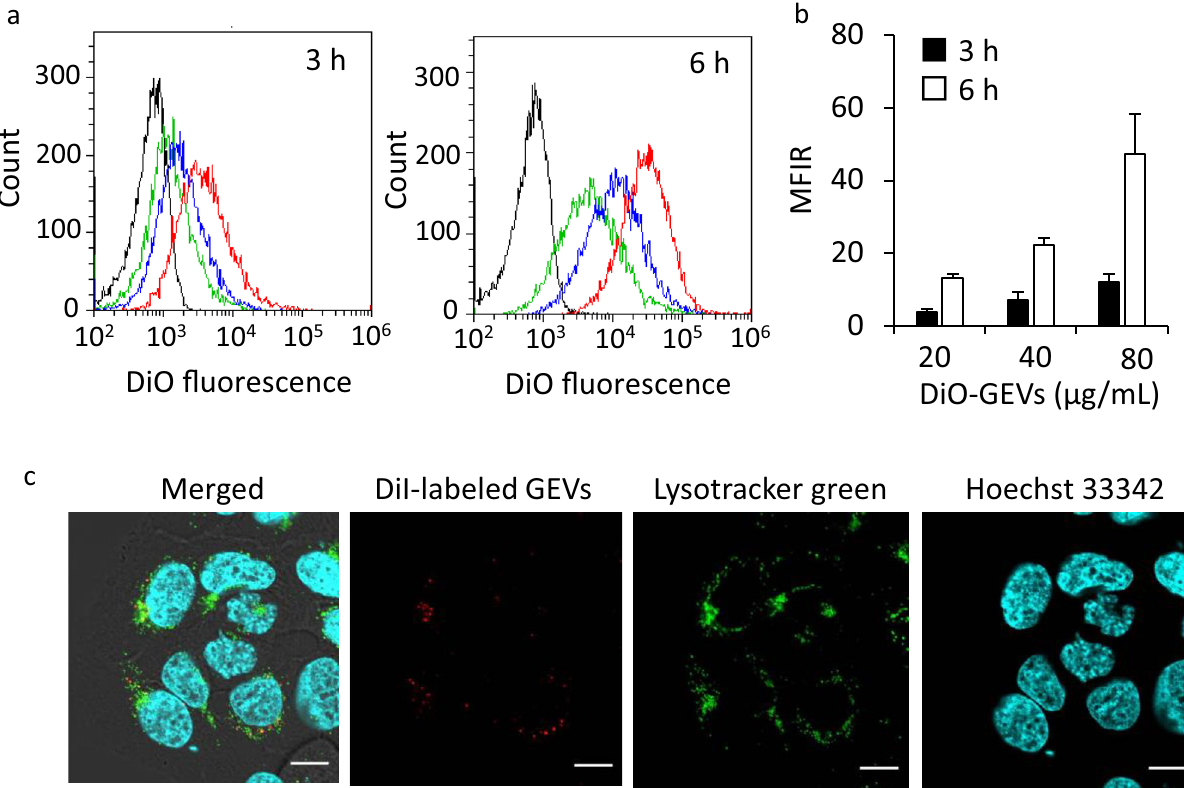
Figure 2. Cellular uptake and intracellular localization of GEVs. ( a ) Representative histogram showing results obtained using flow cytometry (FACS). HaCaT cells were treated with 20 (green line), 40 (blue line), and 80 µg/mL (red line) of 3,3 ′ -dioctadecyloxacarbocyanine perchlorate (DiO)-labeled GEVs and phosphate- buffered saline (PBS; black line) for 3 and 6 h. ( b ) The mean fluorescence intensity ratios (MFIR) obtained for HaCaT cells treated with DiO-labeled GEVs. Data are presented as the mean ± S.D. (n = 3). ( c ) Representative confocal laser scanning microscopy (CLSM) images of HaCaT cells treated with 1,1 ′ -dioctadecyl-3,3,3 ′ ,3 ′ - tetramethylindocarbocyanine perchlorate (DiI)-labeled GEVs (red) for 6 h. Nuclei and lysosomes are stained with Hoechst 33,342 (blue) and LysoTracker DND-26 (green), respectively. Scale bars represent 10 µm.